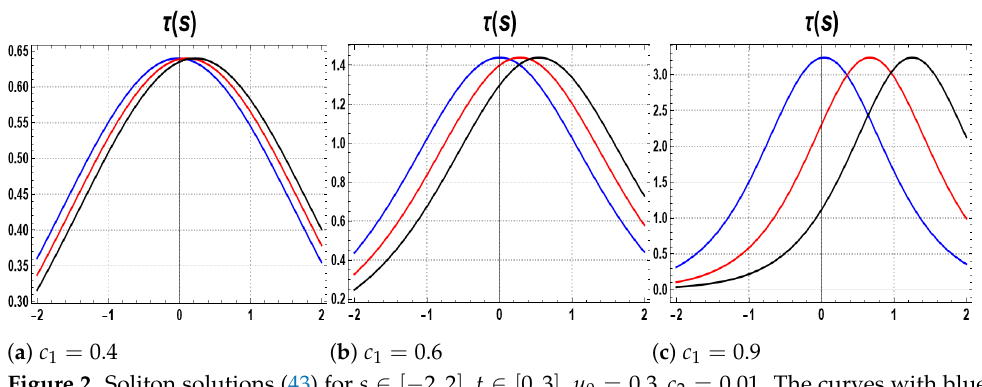
Figure 2. Soliton solutions (43) for s ∈ [ − 2,2 ] , t ∈ [ 0,3 ] , µ 0 = 0.3, c 2 = 0.01. The curves with blue, red, and black colors represent the soliton solutions at t = 0.1,1.4,2.6,